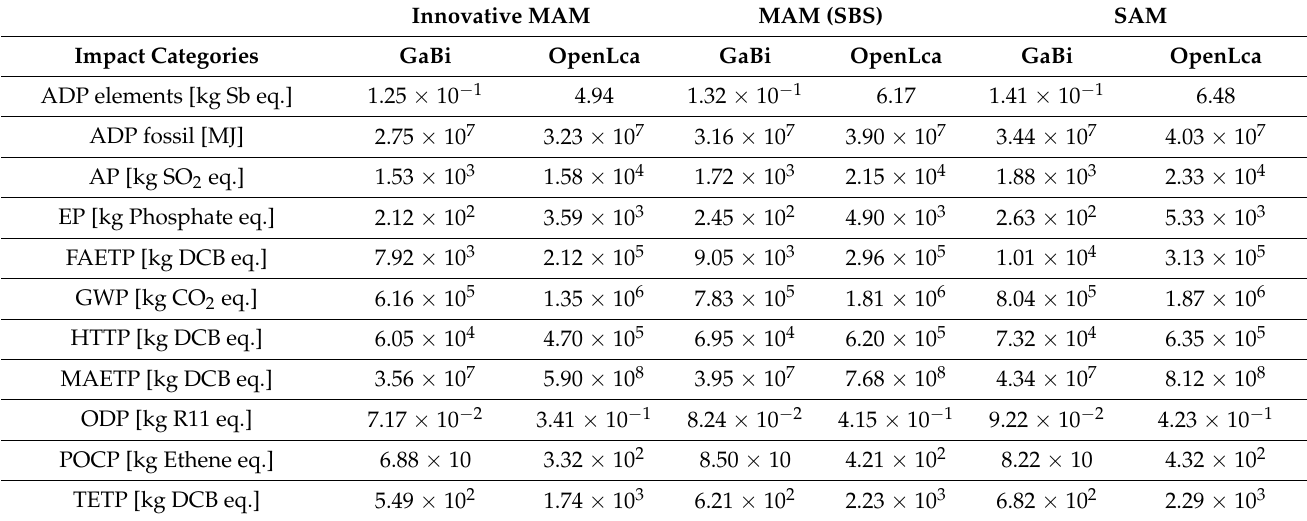
Figure 4. Second case study related to pavements with corresponding layers variable thickness and same stiffness. Comparative environmental impact assessment results for all the impact categories for the three cases SAM, SBS-MAM and innovative -MAM considered obtained by the computation with the GaBi and OpenLCA software. Table 8. Impact results of three cases, innovative MAM, MAM (SBS), SAM, with variable